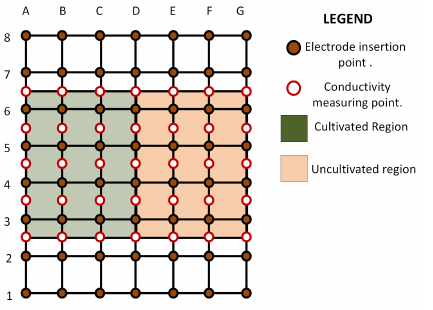
Figure 7. Area delimitation to apply the proposed method to compare σ a